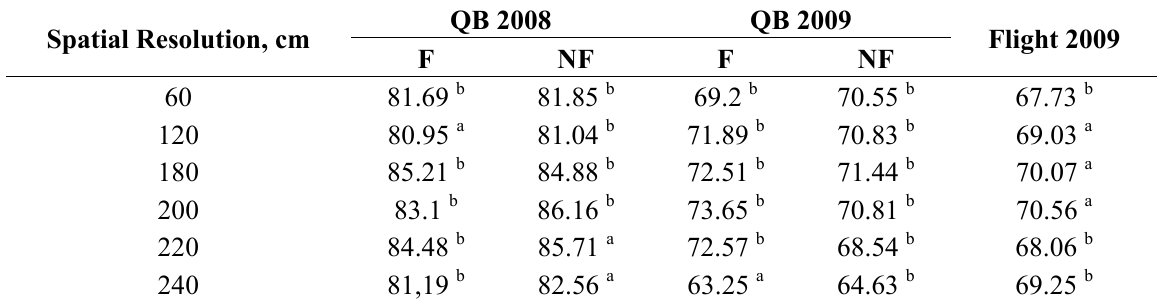
Table 4. Highest values of overall accuracy for the QuickBird and aerial flight images. Values with symbol a and b were classified with the ML and SVM methods,